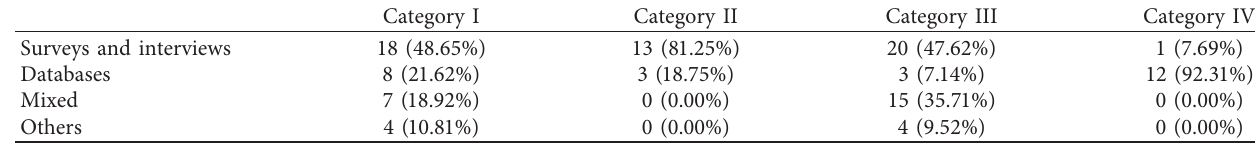
Table 7: Distribution of publications by data sources and categories of network